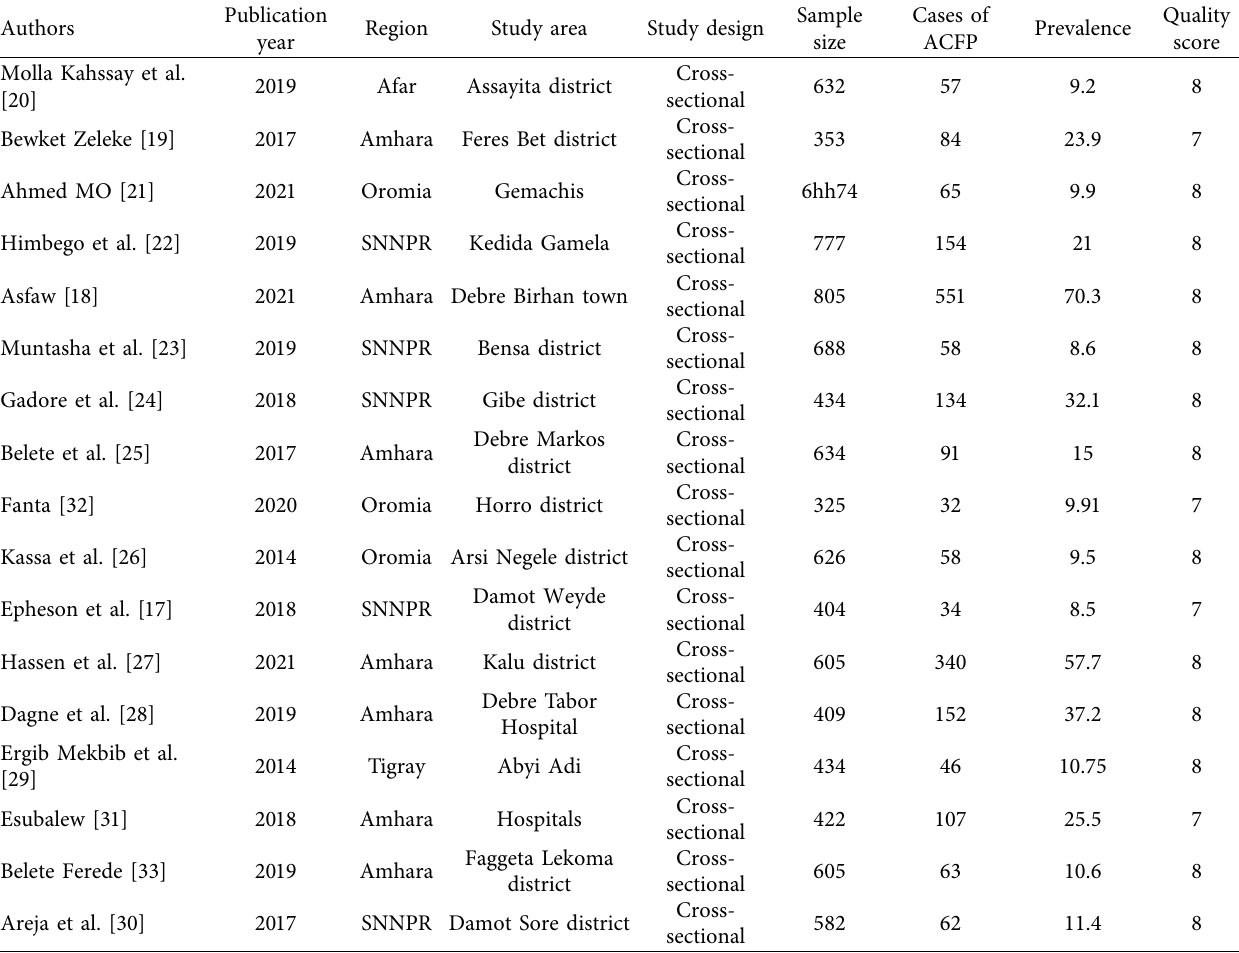
Table 1: Characteristics of included studies presenting the proportion of appropriate complementary feeding of mothers who had infants and young children aged between 6 and 24 months in